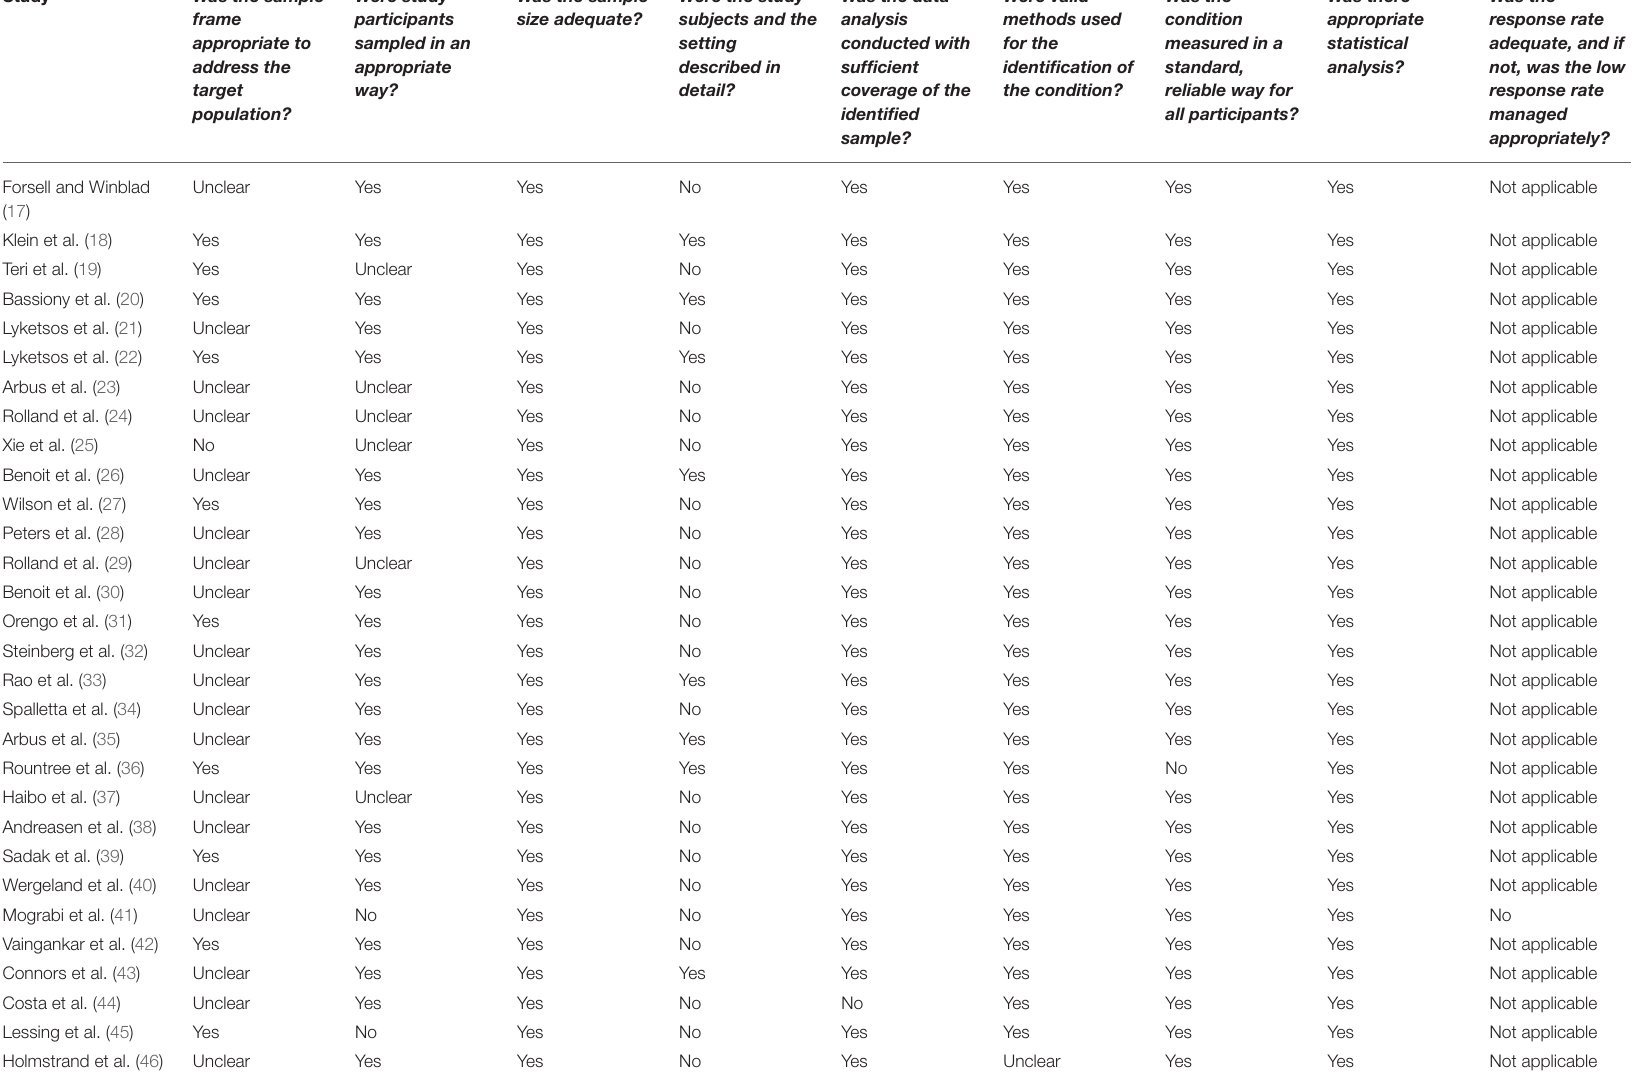
TABLE 2 | Methodological quality of the included